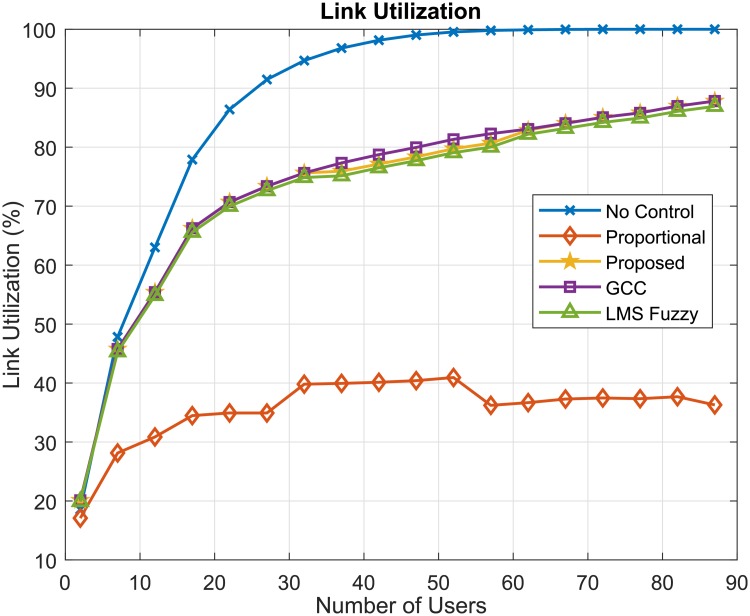
Link utilization (%).